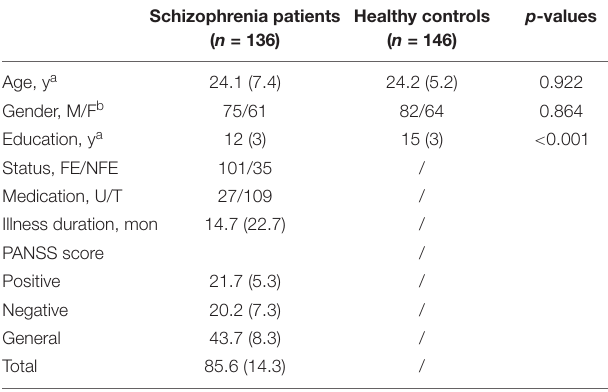
TABLE 1 | Demographical and clinical characteristics.